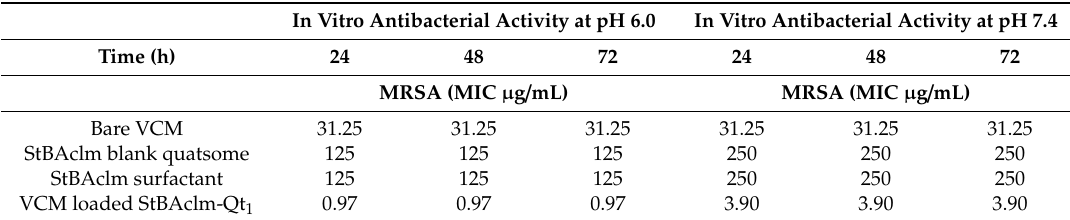
Table4. Minimuminhibitoryconcentrations(MICs)valuesofbareVCM,StBAclm-Qt 1 , andVCM-loaded StBAclm-Qt1 quatsomes against MRSA at pH 6.0 and pH 7.4. In Vitro Antibacterial Activity at pH 6.0